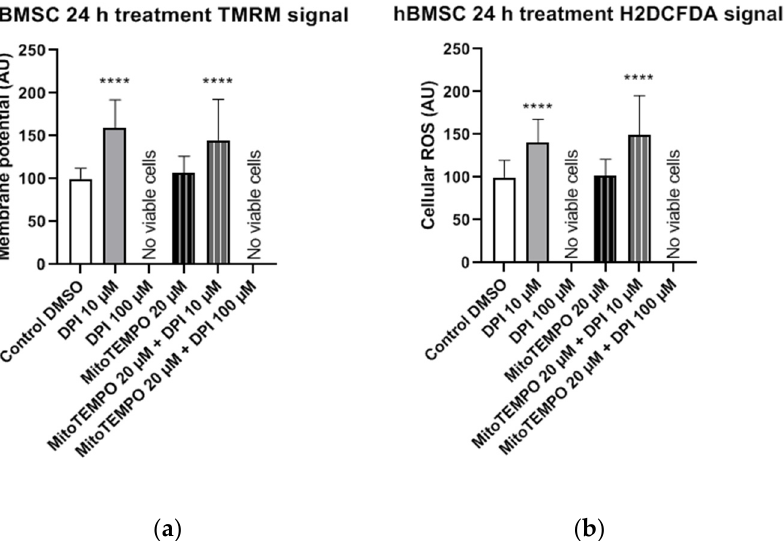
Figure 12. Mitochondrial membrane potential and cellular ROS levels 24 h after the treatment of hBMSCs with diphenyleneiodonium chloride (DPI) and MitoTEMPO. ( a ) Changes in the mitochon- drial membrane potential. ( b ) Changes of the cellular ROS levels. Data is represented as means + SD (error bars) ( n = 36; each point was obtained by analyzing 2–4 single cells. **** p < 0.0001; one-way ANOVA followed by multiple comparison post-hoc Fisher’s LSD test.